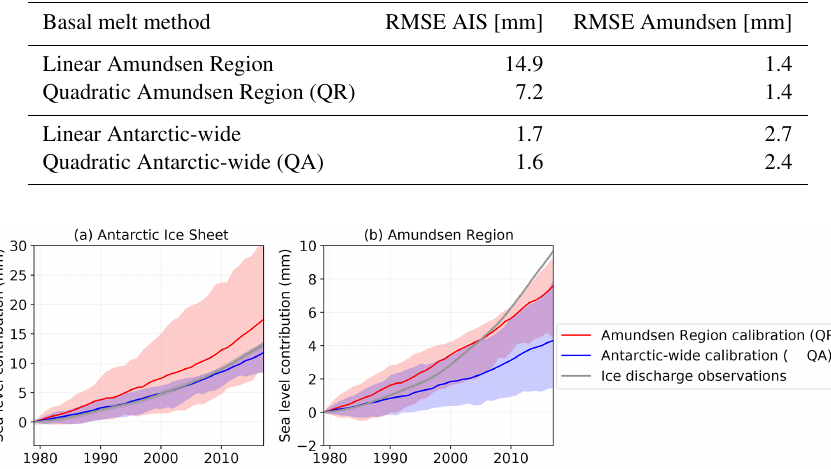
Table 6. RMSEs of the least squares fit of the median sea level contribution of each year, weighted equally, between calibrated results and ice discharge observations of Rignot et al. (2019). Results are shown for combinations of the two parameterisations, linear and quadratic (Q) and two calibration methods, on the Amundsen Region (R) and Antarctic-wide (A), for two hindcast regions: Antarctic ice sheet (AIS) and the Amundsen Region.